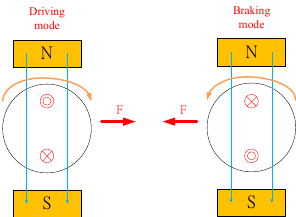
Figure 1. Amp è re’s circuital law for motor driving and braking. Figure 1. Ampère’s circuital law for motor driving and braking.